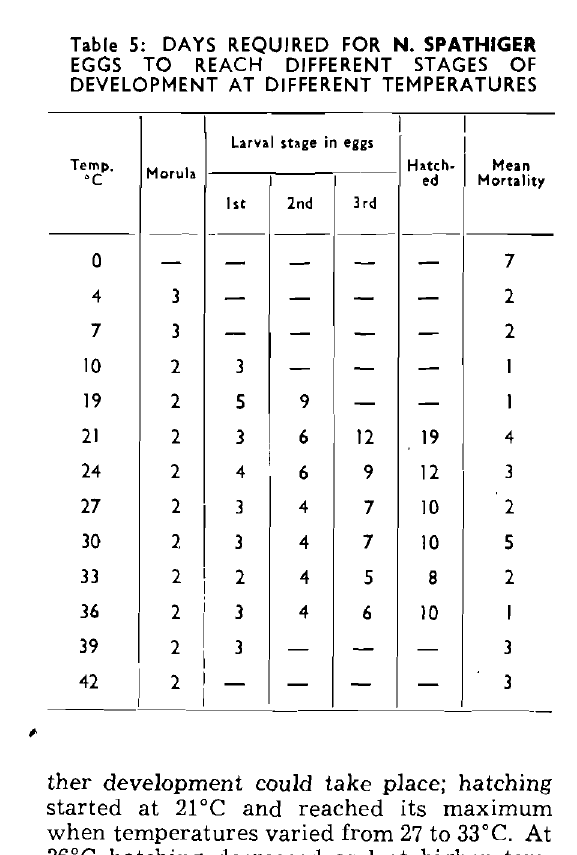
Table 5: DAYS REQUIRED FOR N. SPATHIGER EGGS TO REACH DIFFERENT STAGES OF DEVELOPMENT AT DIFFERENT